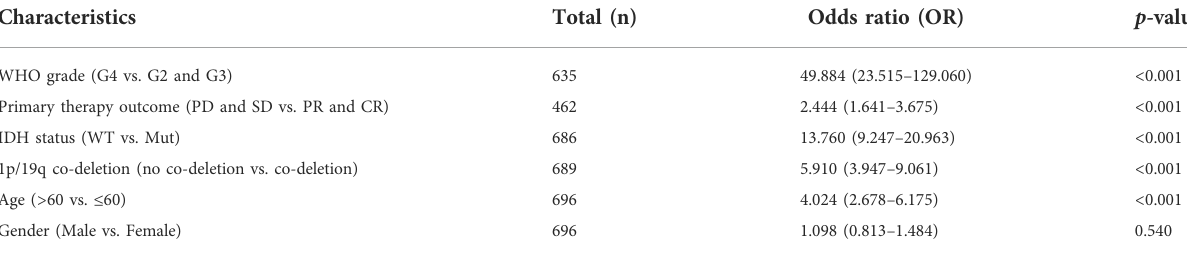
TABLE 2 Association of CENP-A expression with the clinicopathological characteristics of patients with glioma (logistic regression). Characteristics Total (n) Odds ratio (OR) p